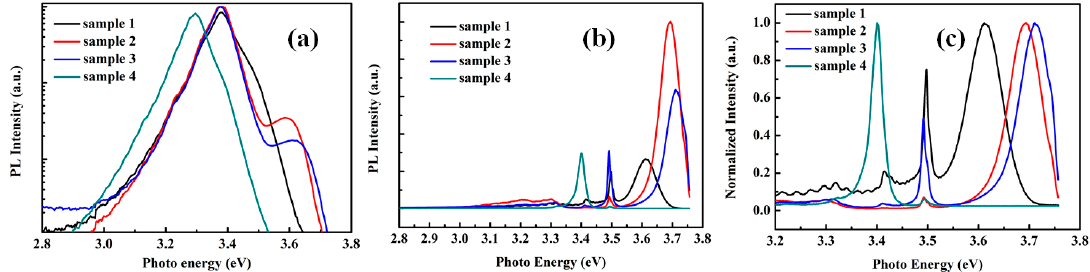
Figure 5. Photoluminescence spectra of the AlInGaN samples at fixed excitation. ( a ) Room temperature; ( b ) at 10 K; and ( c ) normalized photoluminescence spectra for AlInGaN samples at a temperature of 10 K.